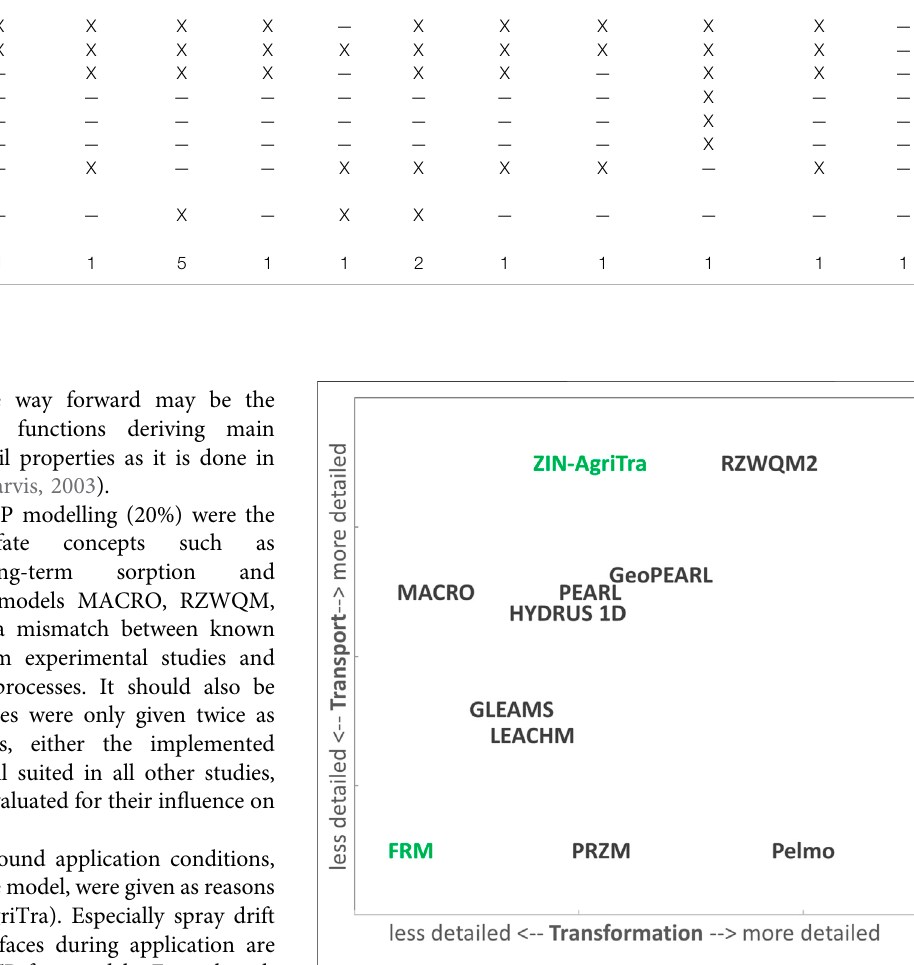
FIGURE 3 | Level of detail of transformation and transport (i.e. hydrological) processes implemented in the models. For better visibility, models may have been shifted on the Transport axis (black: leaching models; green: catchment